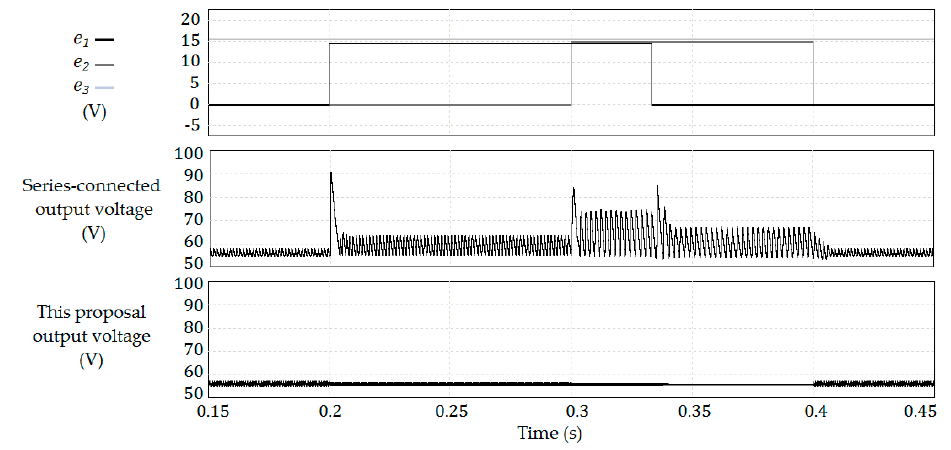
Figure 9. Series-connected boost vs the proposed circuit, output voltage comparison against changes in the power sources with a PI, closed-loop control.